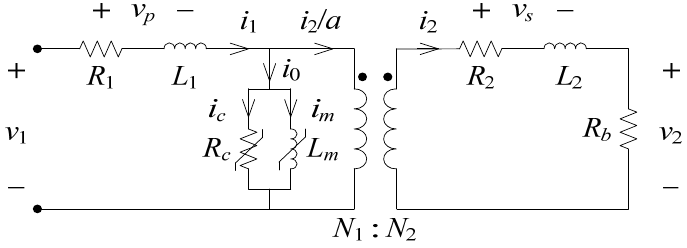
Figure 1. Equivalent circuit of the VT. v 1 , v 2 : primary and secondary voltages; v p , v s : primary and secondary winding voltages; i 1 , i 2 : primary and secondary currents; i 0 , i c , i m :